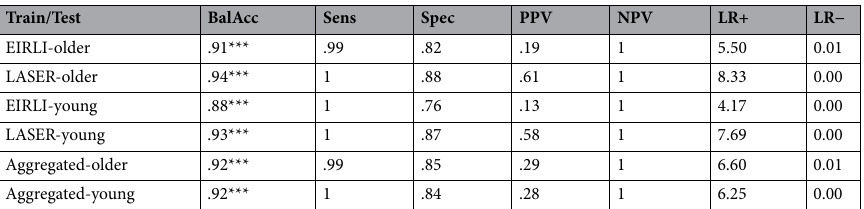
Table 1. Model performance on each dataset when trained and tested using repeated-cross validation. ***Balanced accuracy significantly exceeds baseline balanced accuracy of .50 where all cases are classified as normal, all p values <